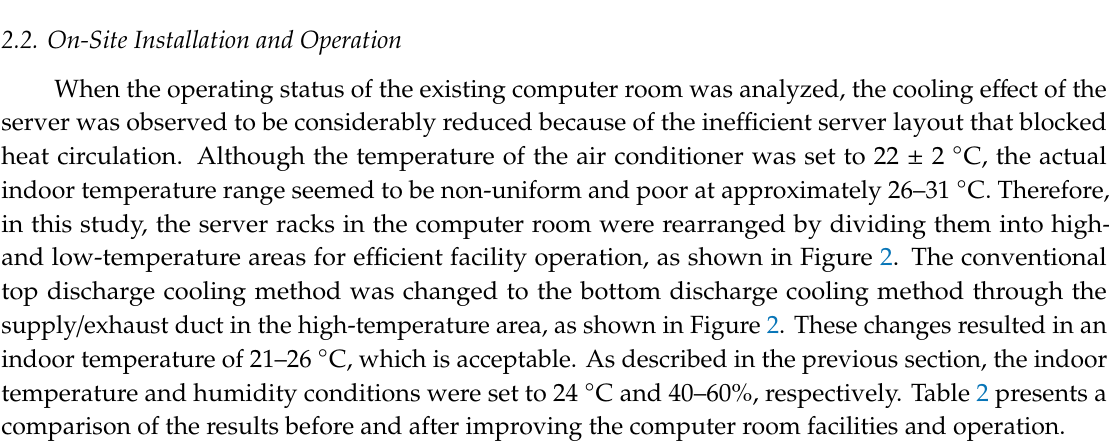
Table 2. Comparison of indoor conditions before and after the improvements.